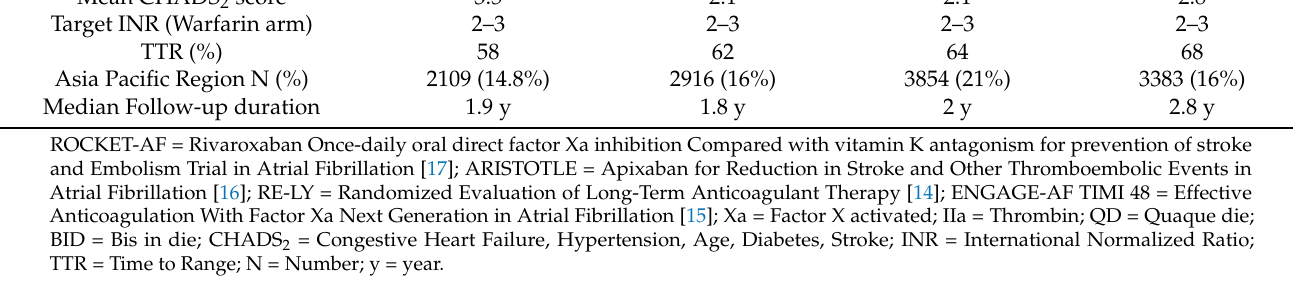
Table 3. Patients with and without diabetes in the pivotal trials.